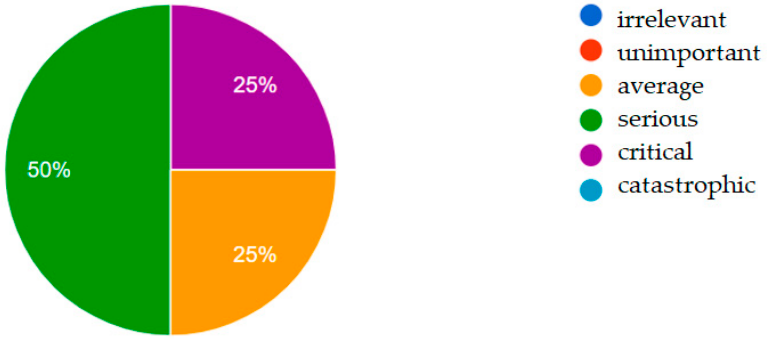
Figure 7. The severity of the disruption in the supply chain.